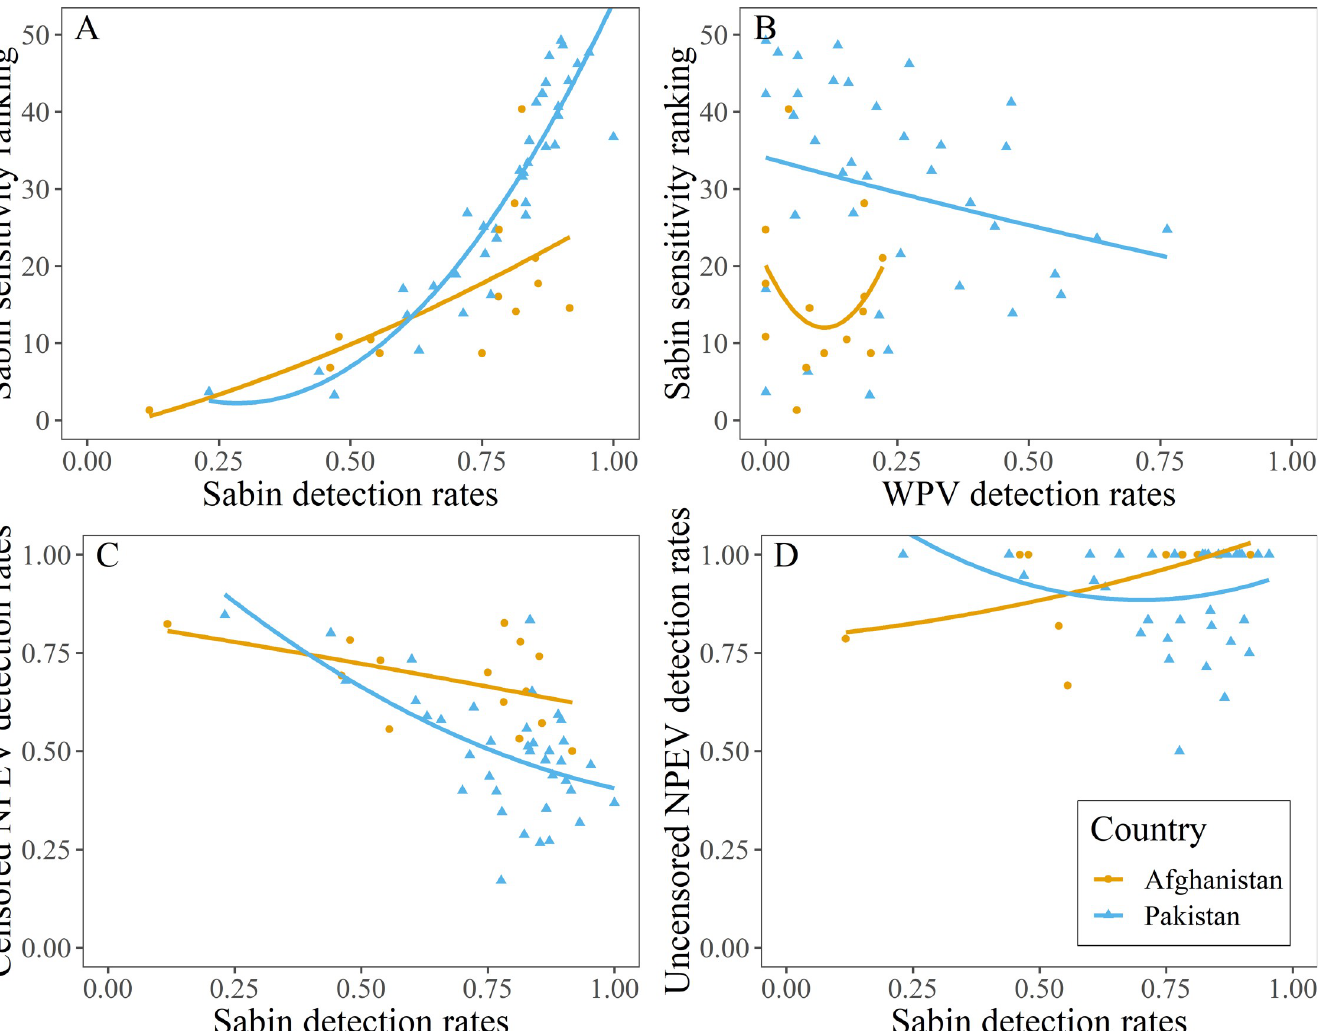
Fig 5. Correlations between model rankings and raw detection rates. Panel A illustrates the positive relationship between ES site sensitivity model rankings (averaged across SL1, SL2, and SL3) from low (small numbers) to high (high numbers) and detection rates of any type of Sabin at each site. Panel B shows the relationship between ES site sensitivity model rankings and WPV detection rates. Panel C shows the negative relationship between NPEV and Sabin detection rates across all samples, including those where polio was detected and could potentially censor NPEV reporting. Panel D shows the relationship between NPEV and Sabin detection rates when we correct for the potential censoring by only including NPEV results for samples without any poliovirus detections. The line represents a loess smoother fit to the data.